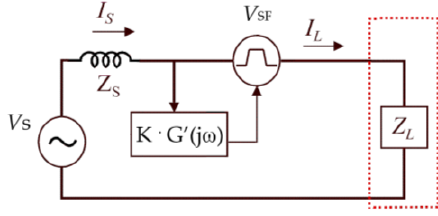
Figure 7. Proposed synchronous reference frame (SRF)-based compensation algorithm for the series filter (SF). Vref: voltage references.